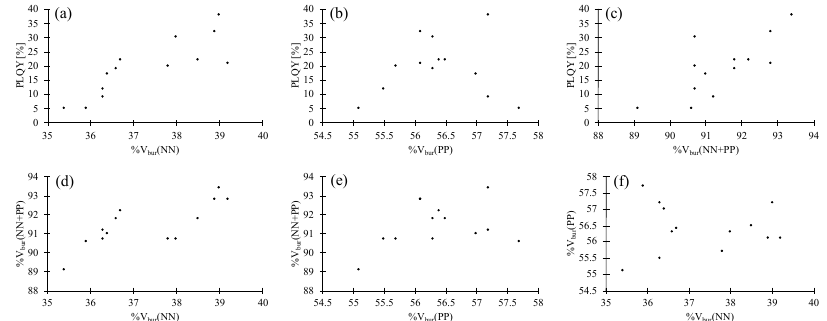
Figure 5. Scatter plots of PLQY, %V bur (NN), %V bur (PP) and %V bur (NN + PP) for compounds 2a/b – 7a/b [26]. ( a ) Scatter plot of PLQY vs. %V bur (NN). ( b ) Scatter plot of PLQY vs. %V bur (PP). ( c ) Scatter plot of PLQY vs. %V bur (NN + PP). ( d ) Scatter plot of %V bur (NN) vs. %V bur (NN + PP). ( e ) Scatter plot of %V bur (PP) vs. %V bur (NN + PP). ( f ) Scatter plot of %V bur (NN) vs. %V bur (PP). For PˆP = Xantphos: bpyOPh < bpyOMe ≈ bpyOEt < bpySEt ≈ bpySPh ≈ bpySMe For PˆP = POP: bpyOPh < bpyOMe ≈ bpyOEt < bpySPh ≈ bpySMe <